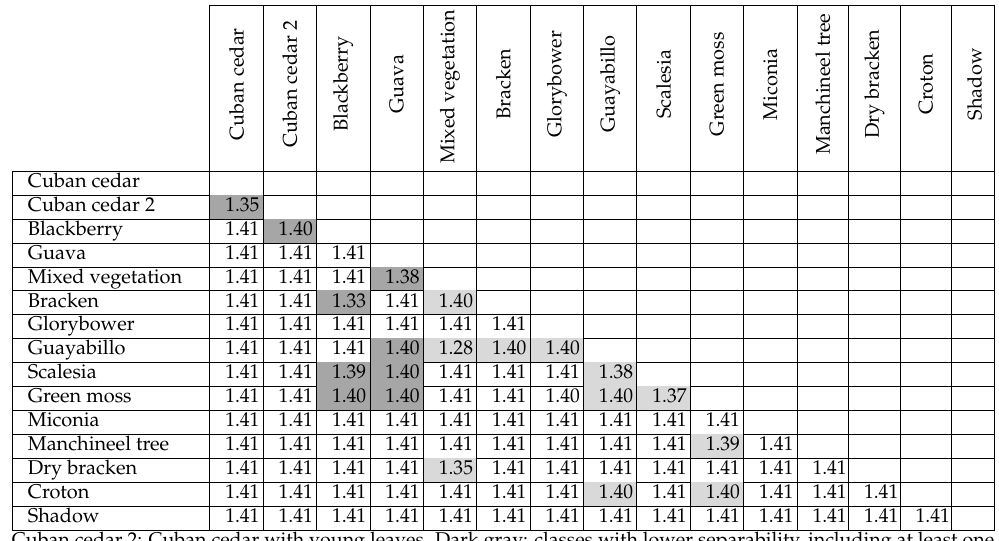
Table 2. Jeffries–Matusita distance (JMD) table calculated from the spectral values of the training samples taken from WV-2 image captured in March 2016. JMDs involving guayabillo were derived from a JMD table calculated from the March 2013 WV-2 image, because the guayabillo samples were not sufficiently represented in the March 2016